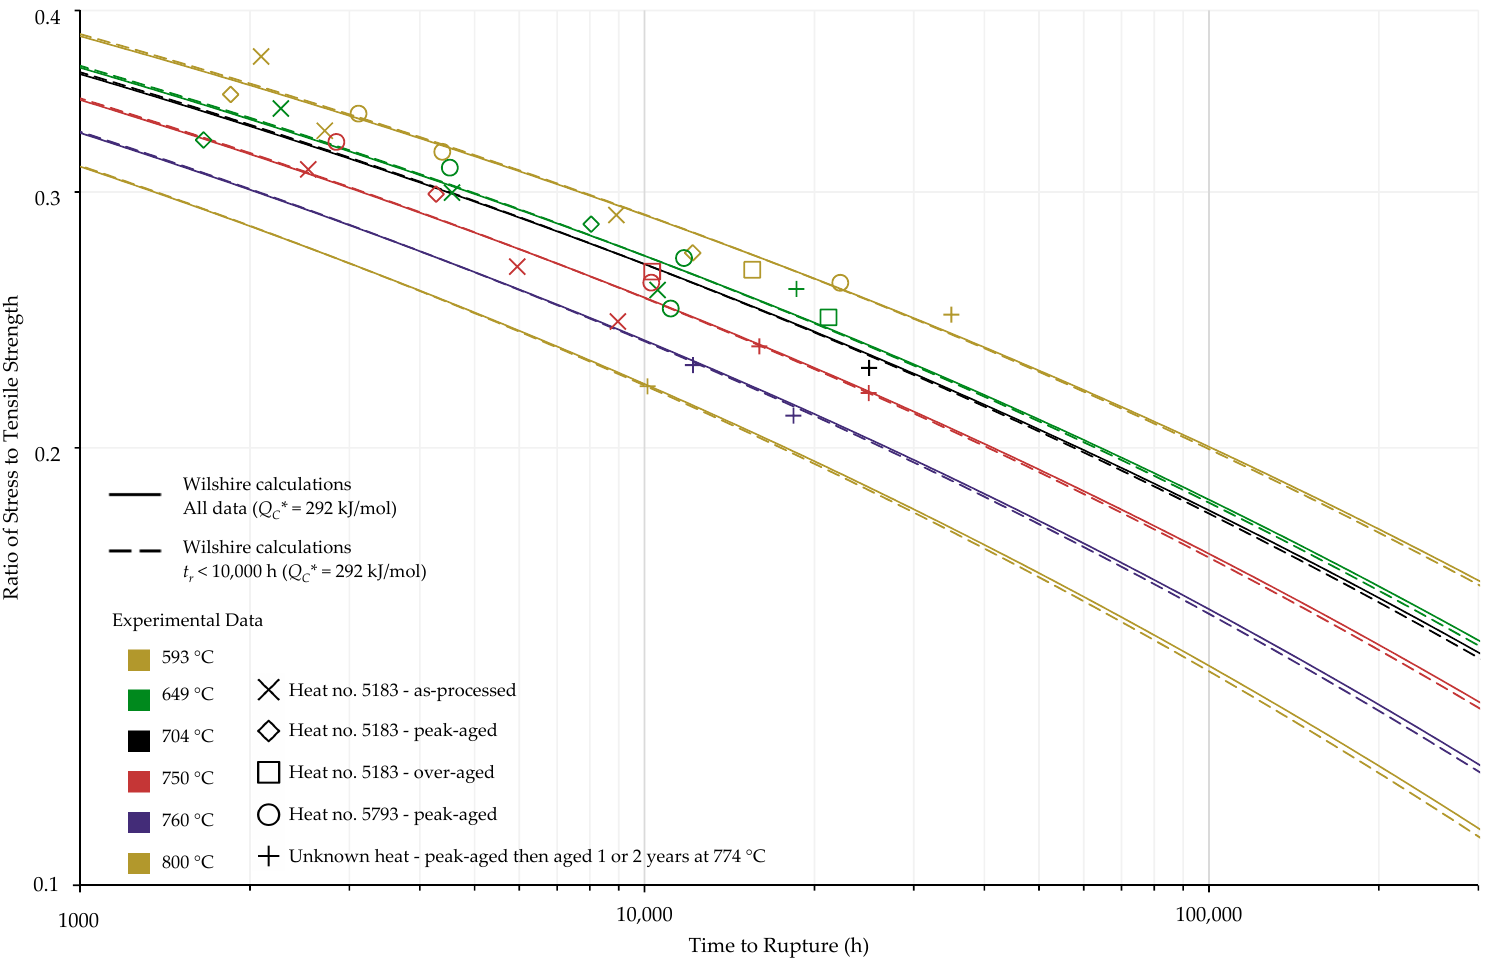
Figure A19. Calculations of the Wilshire equation for Nimonic 105 using heat- and processing-specific tensile strength values with the self-diffusion activation energy of nickel in a nickel lattice as Q ∗ C